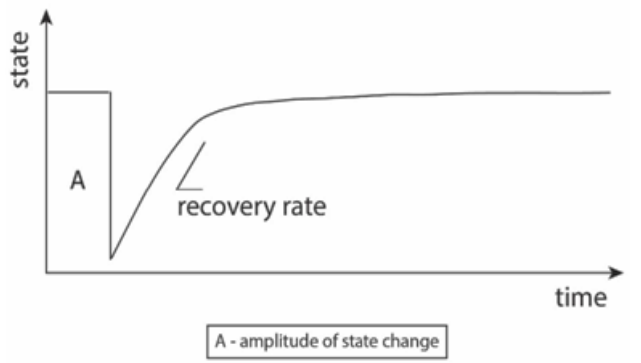
Fig. 1. System response to a shock